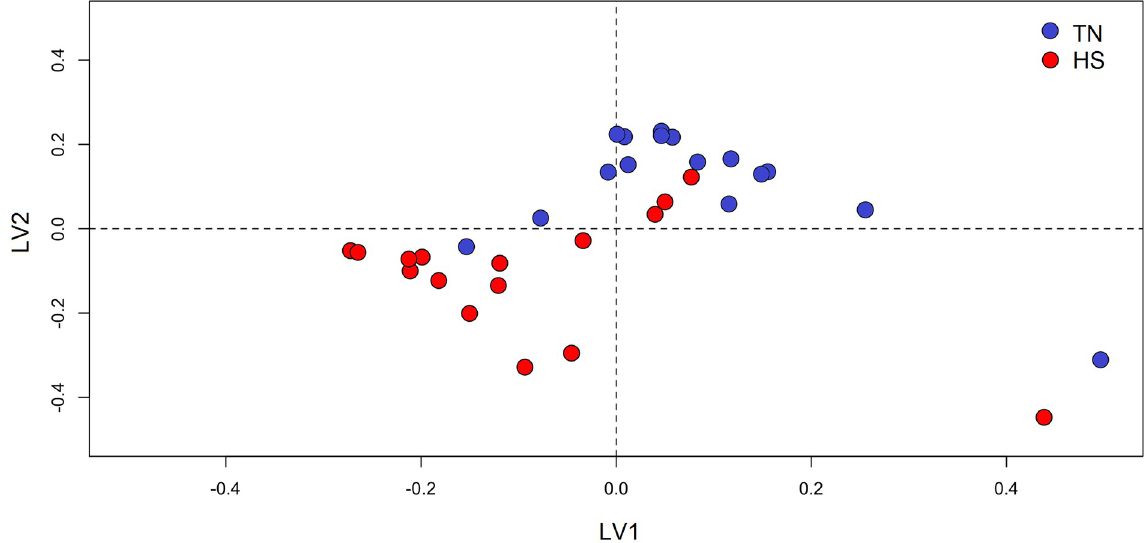
Fig 3. PLS-DA scores plot of the first two principal components of 1 H NMR urinary spectra of thermoneutral (TN) and heat-stressed (HS) lactating dairy does.